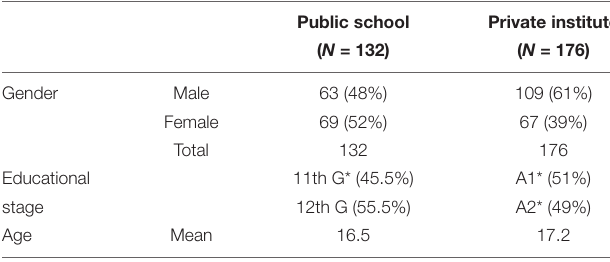
TABLE 1 | The participants’ demographic